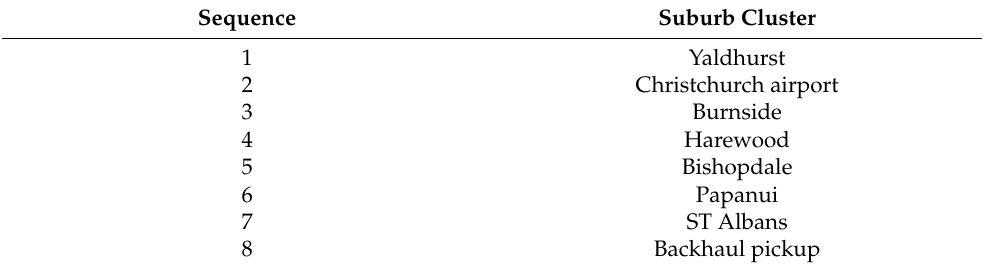
Table 4. Truck delivery suburb sequence.